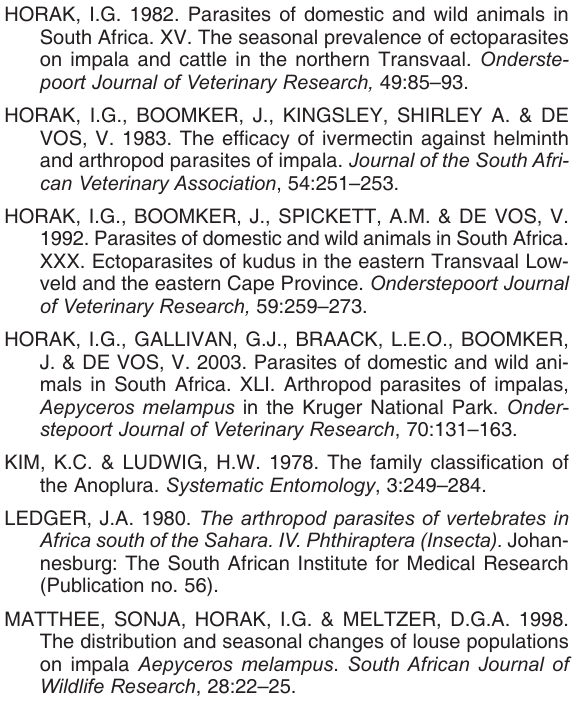
TABLE 2 Distribution of Linognathus spp. on the bodies of impalas Louse